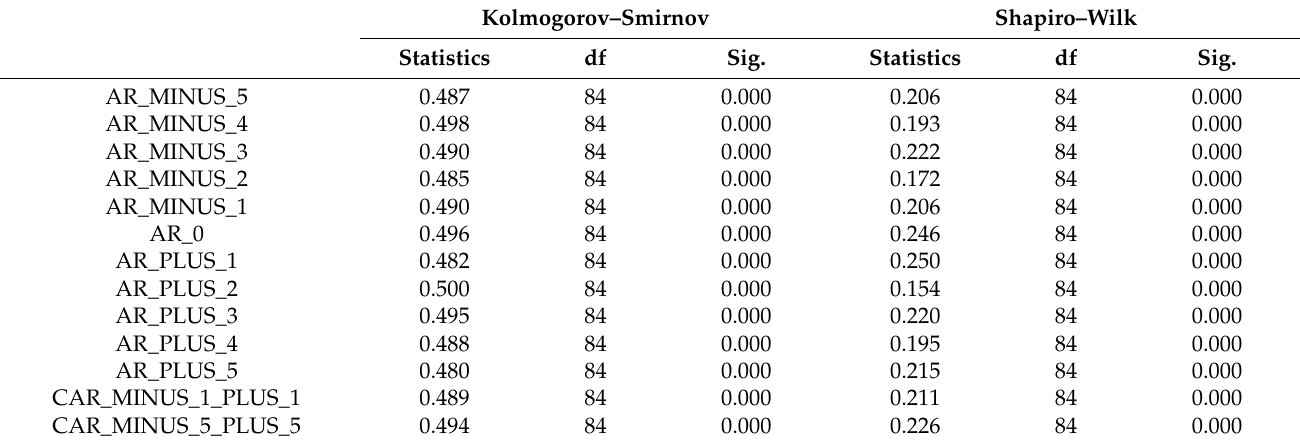
Table 2. Normality tests—Initial data